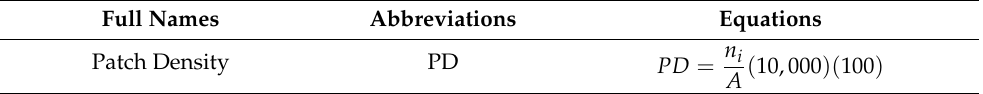
Table 2. Full names, abbreviations and equations of each landscape ecological